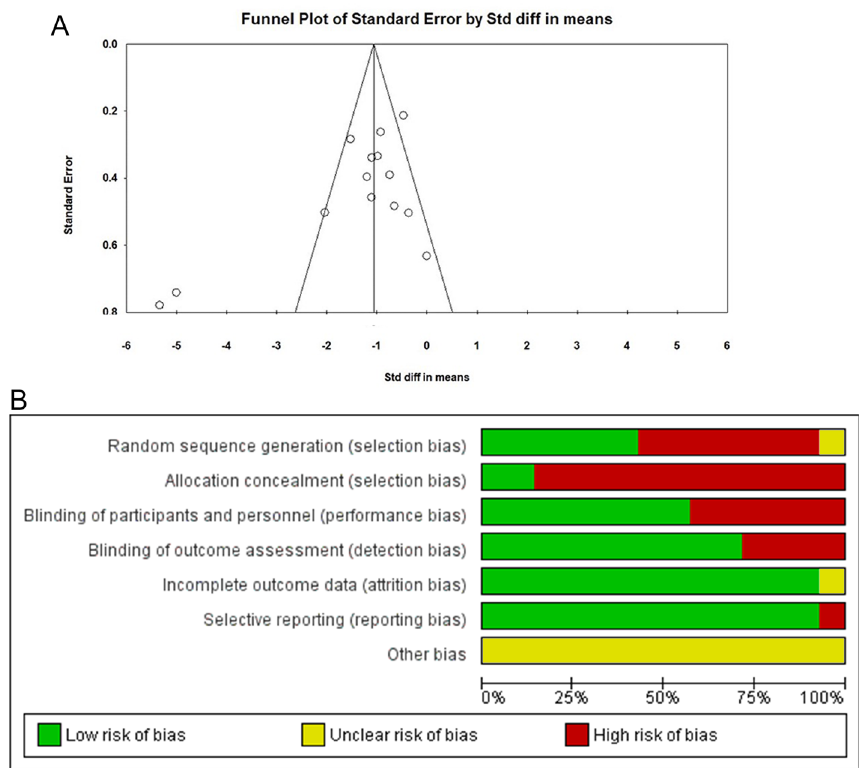
Figure 7. ( A ) Funnel plot for the meta-analysis of strength training such as treatment of hypertension. Egger’s test (P = 0.01729) shows a significant publication bias. Beck et al. 26 and Moraes et al. 33 are the biggest outliers. ( B ) Risk of bias